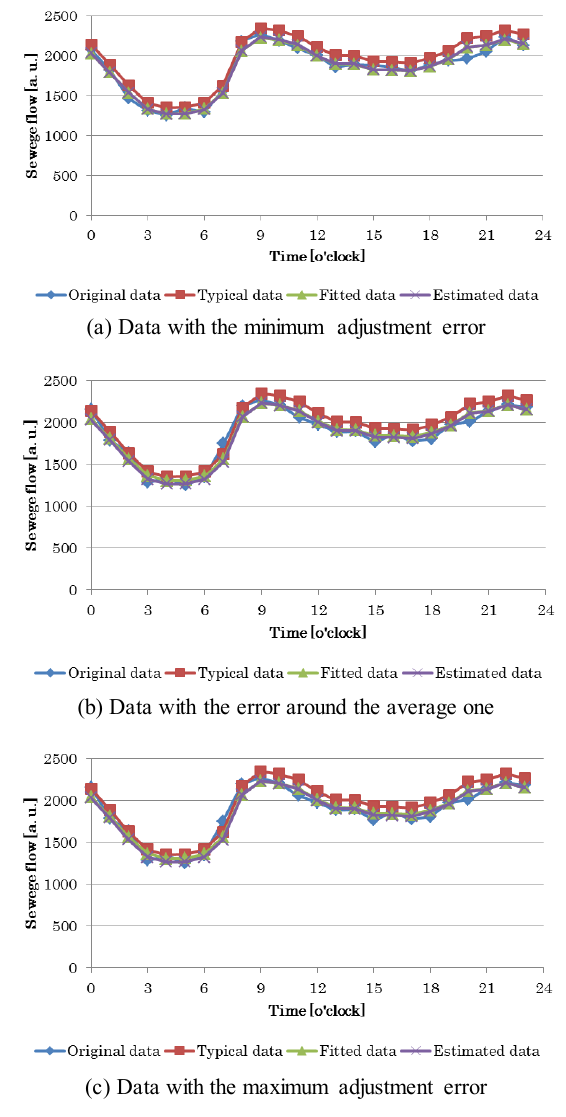
Fig. 4. Estimation of flow patterns without considering day